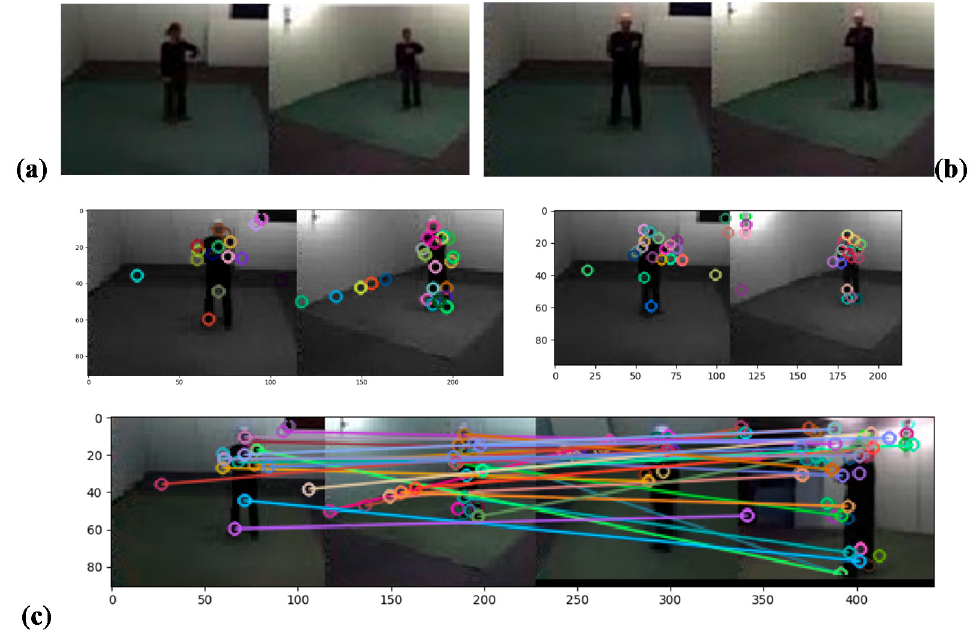
Figure 4. ( a ) Powerful view-invariant feature for two subjects acting in the same environment; ( b ) our algorithm selects the zone of interest, extracts share; and private features; and ( c ) clear mapping among views.